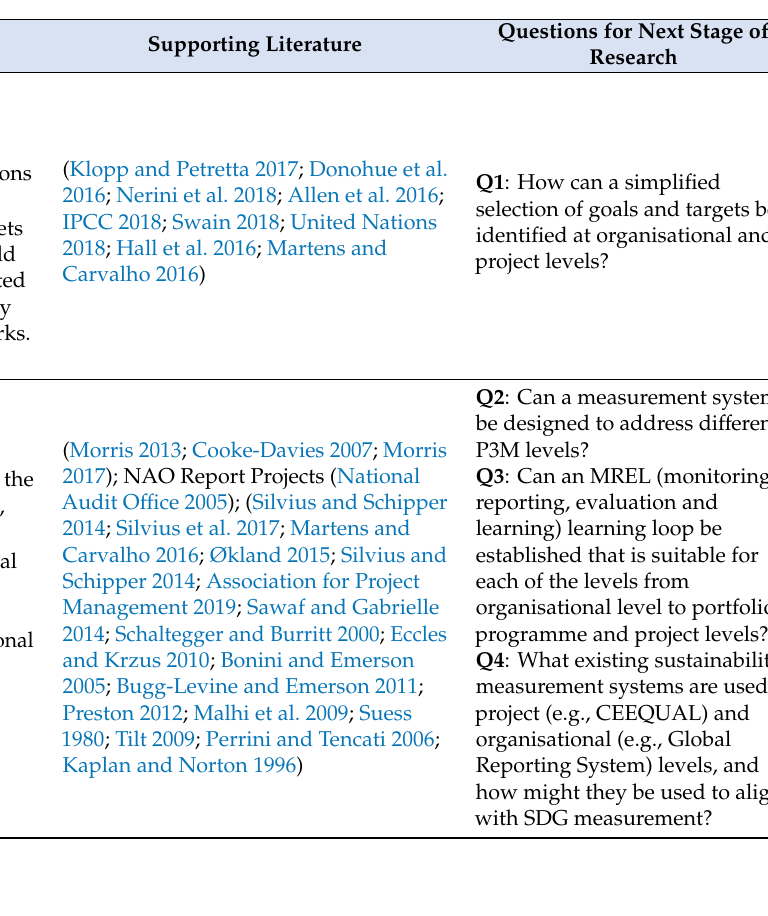
Table 3. Summary of conceptual development of a future prototype model for SDG measurement, based on the survey results in this study, including questions & sub-questions, supporting literature and corresponding